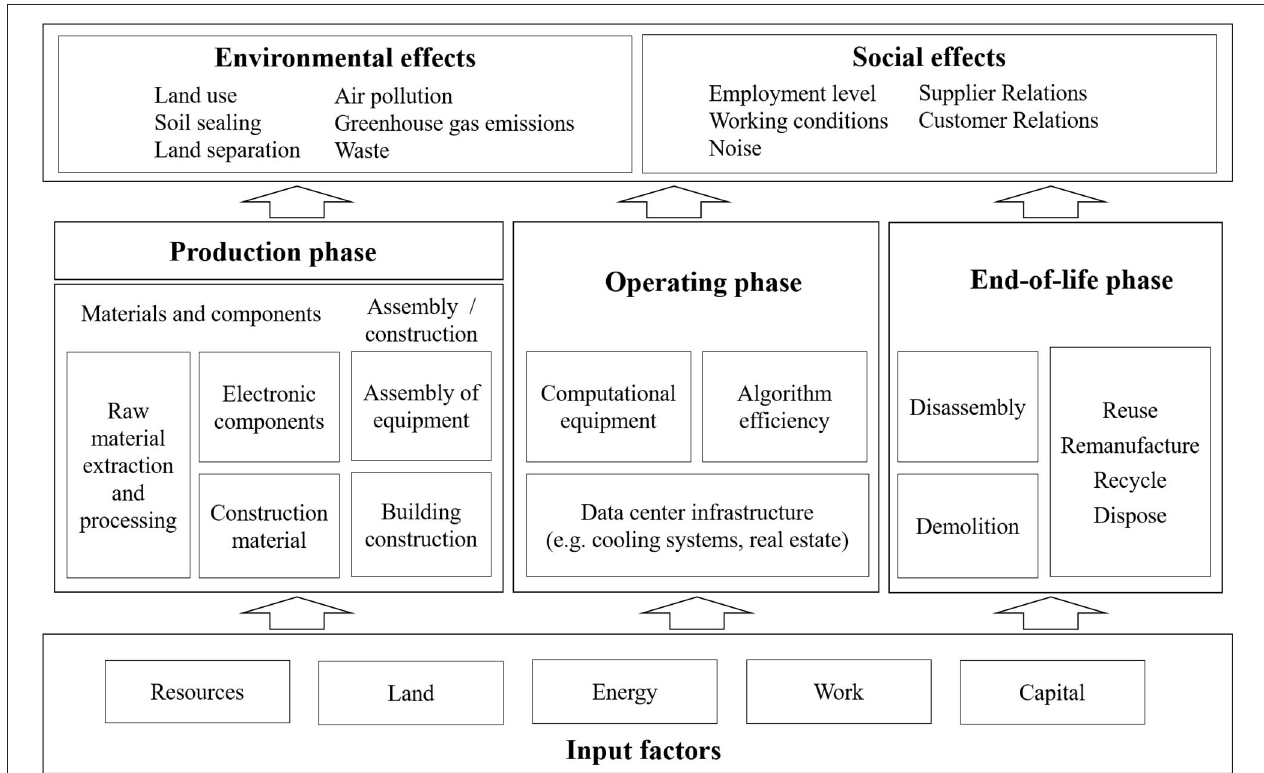
FIGURE 1 | Main input factors, environmental and social effects along the smart contract supply chain.